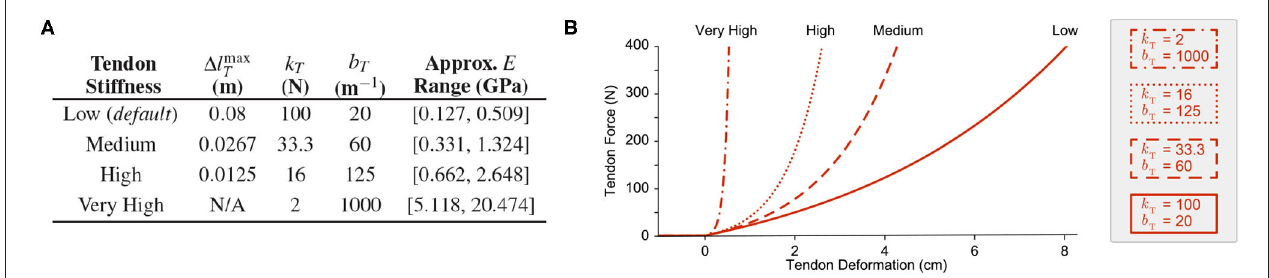
FIGURE 2 | (A) Tendon stiffness parameters and the approximate range of Young’s modulus values. (B) Examples of tendon tension-stretch curves for the parameters provided in (A) . The Low stiffness curve ( solid red ) represents the default force-length relationship for the compliant tendons proposed in Hagen et al.